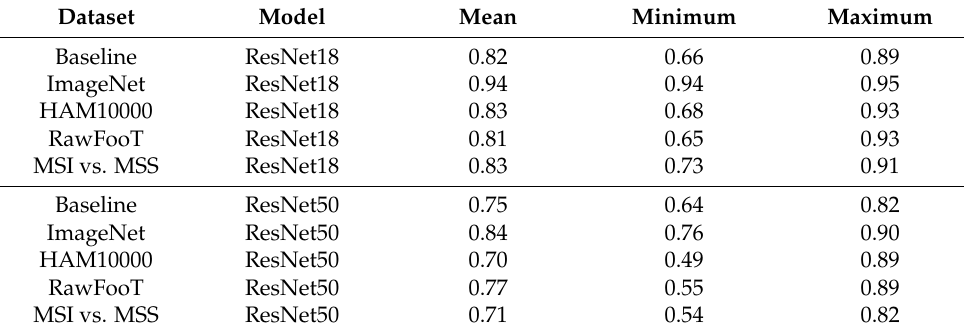
Figure 7. Test set accuracy for the transfer learning experiments: ( a ) accuracy for fine-tuned ResNet18 and ( b ) accuracy for fine-tuned ResNet50. Solid bars indicate the mean accuracy values. Black lines indicate minimum and maximum accuracy values. Blue bar on top indicates the baseline models trained with randomly initialized weights, as discussed in the text. The mean, minimum, and maximum values are shown in Table 7. Table 7. Accuracies displayed in Figure